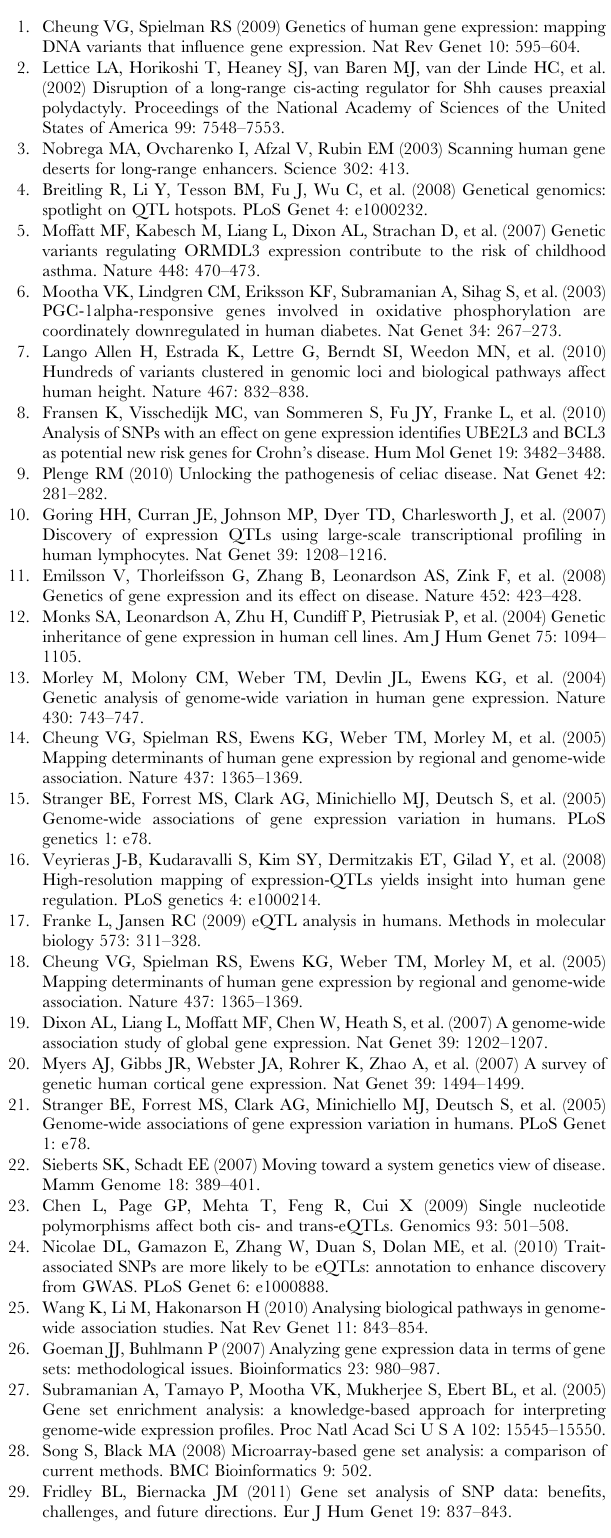
Table S1 Categories of Gene